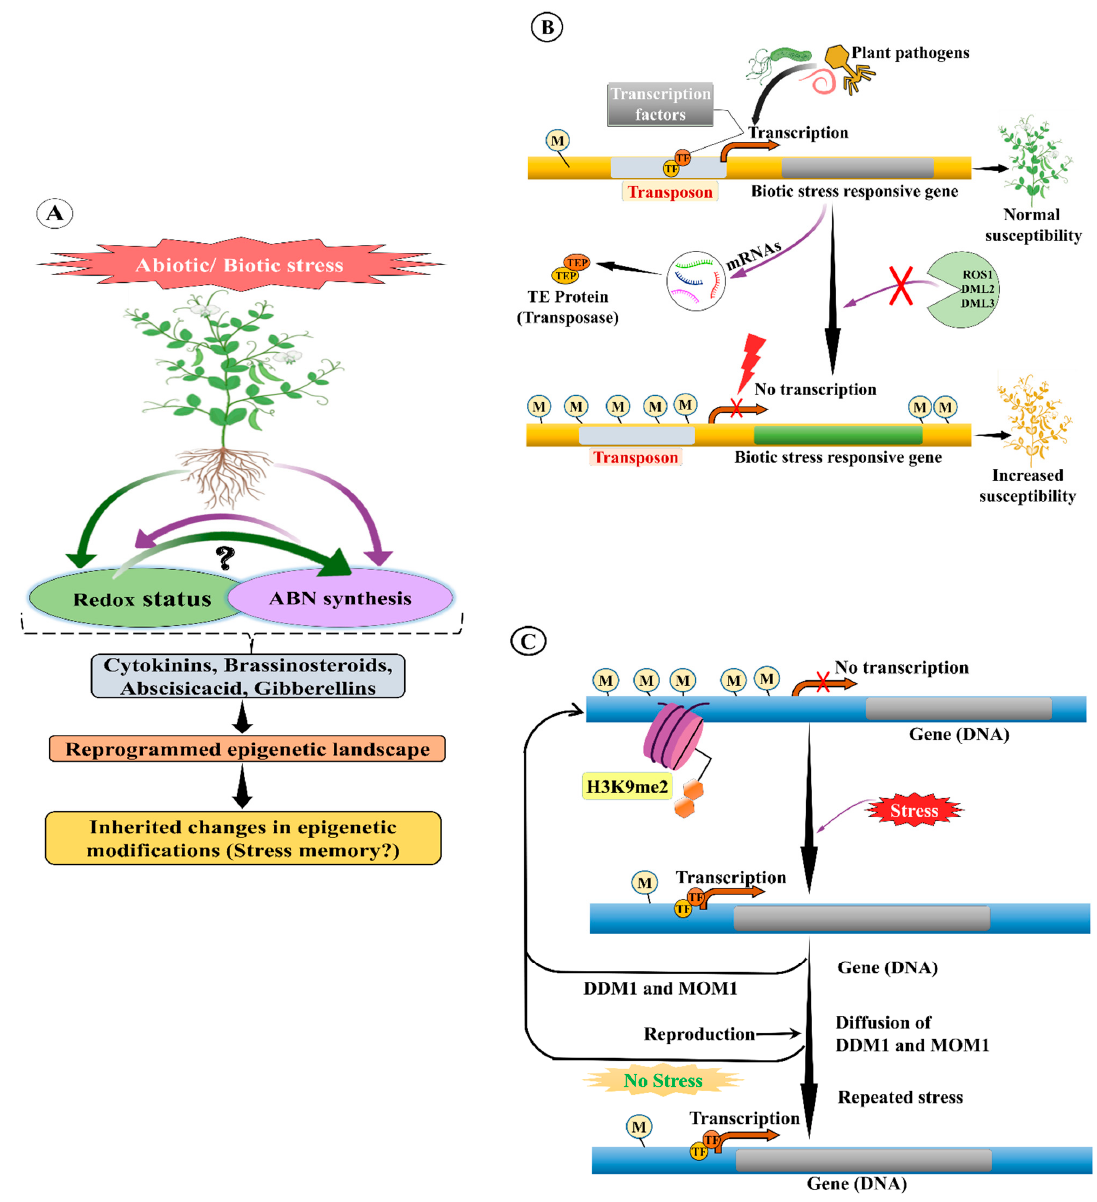
Figure 5. Epigenetic modifications under stress conditions and possible stress memory. ( A ) Both biotic and abiotic stresses can induce or change DNA methylation (5-methylcytosine, mC) and induce other epigenetic changes in the genome; such modifications are associated with the expression of stress-response genes, which conversely may lead to epigenetic processes. Reprogrammed epigenetic modifications (stress memory) are inherited by the offspring. ( B ) In Arabidopsis , ROS1, DML2, and DML3 remove DNA methylation, thus collectively regulating stress responsive genes in their vicinity. Defects in demethylases, such as ROS1, DML2 and DML3, exhibit increased susceptibility to the fungal pathogen Fusarium oxysporum [315]. ( C ) During Arabidopsis recovery from heat stress, DDM1 and MOM1 regulate the deletion of stress-induced epigenetic memory. Mutations in DDM1, a chromatin remodeller, assuages transcriptional silence with a significant loss of DNA methylation. MOM1 intermediates facilitate transcriptional silence via an unknown mechanism without loss of DNA methylation. Dysfunction of DDM1 and MOM1 in heat stress-induced gene de-silencing can be inherited in plants exposed to repeated stress [316]. ROS1, repressor of silencing 1; DMEL2 and DML3, transcriptional activator demeter (DME)-Like 2 and 3, respectively; DDM1, decreased DNA methylation 1; MOM1, morpheus molecule 1; H3K9me2, demethylated histone H3 lysine 9. The illustration was adapted and redrawn from Zhang et al. [42], with copyright permission from the Licensor Springer Nature (Nature Reviews Molecular Cell Biology: Nature publisher) and Copyright Clearance Center (https://www.copyright.com) (Supplementary File